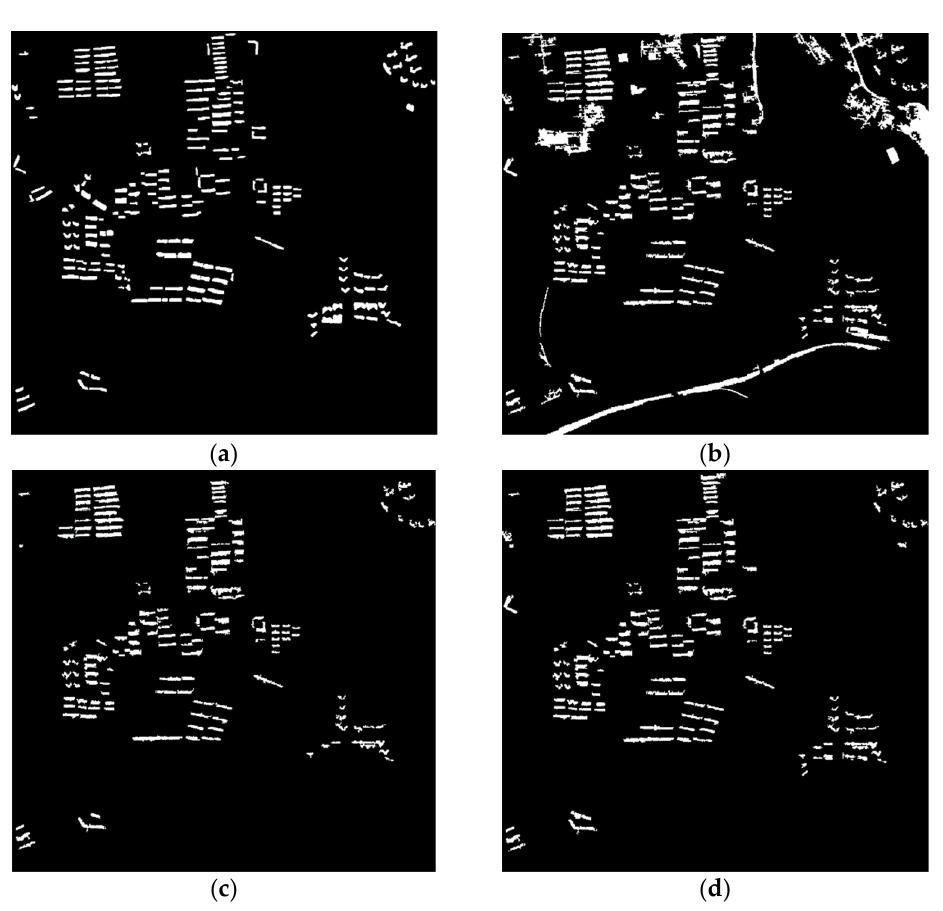
Figure 8. HRB detection results from Site 1. ( a ) Reference data; ( b ) HRB detection result by MBI; ( c ) HRB detection result by MBI with shadow intensity [42]; and ( d ) HRB detection result by MBI with digital maps. Table 4. Accuracy of HRB detection for Site